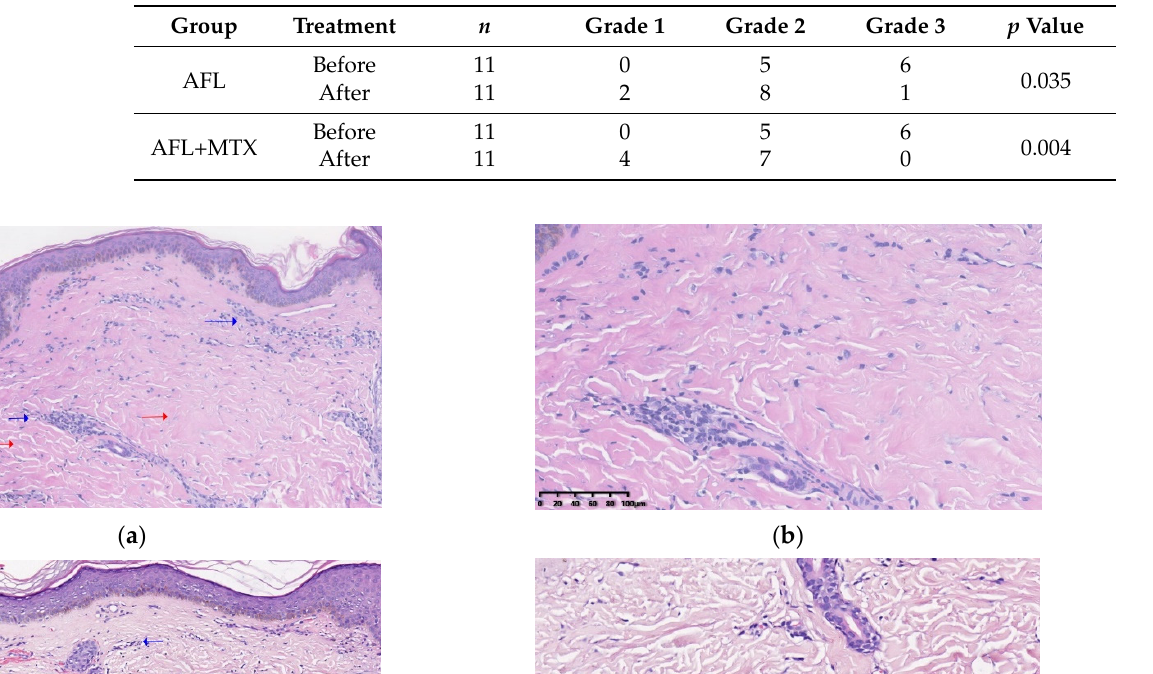
Table 4. The histological grade of fibrosis four weeks before and after treatment. AFL group was treated by ablative fractional laser and AFL+MTX group was treated by ablative fractional laser- assisted delivery of methotrexate.